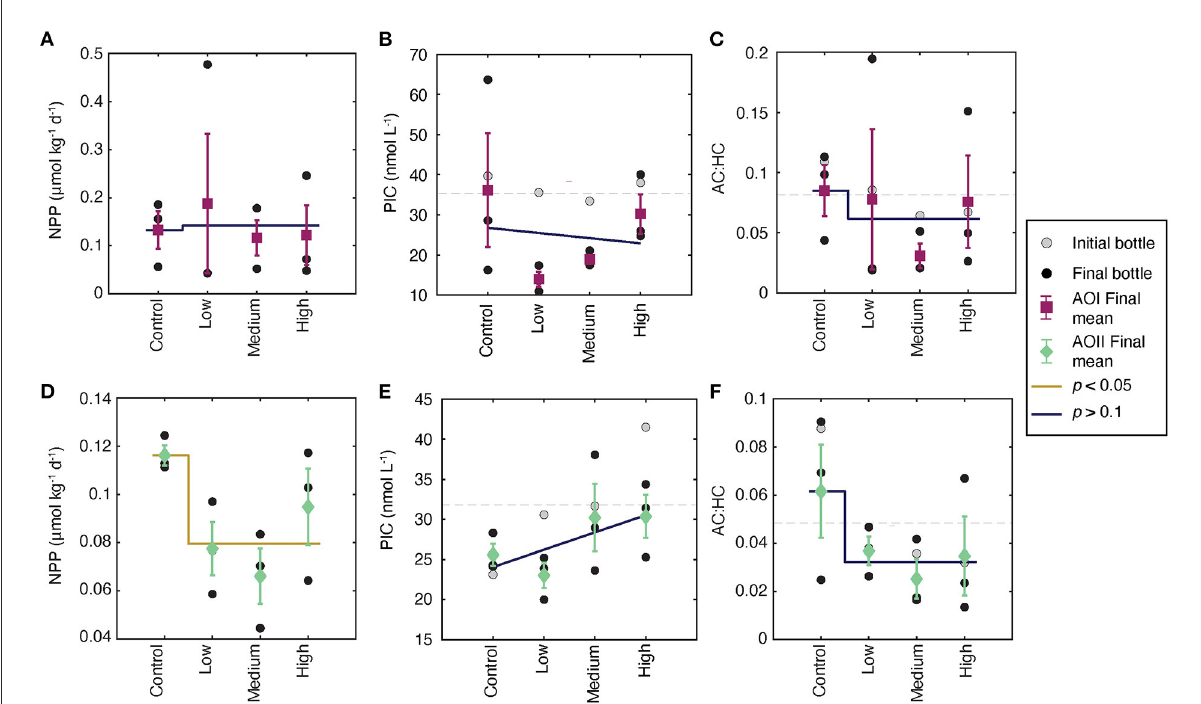
FIGURE5 Particulate data collected from each incubation at AOI (A–C) and AOII (D–F) . (A) Net primary production (NPP) as calculated in Equation 1. (B) PIC concentration in nanomoles per liter. (C) The autotrophic to heterotrophic count ratio (AC:HC). (D–F) Are the same as (A–C) , but for AOII. All symbols, colors, and lines are the same as in Figure